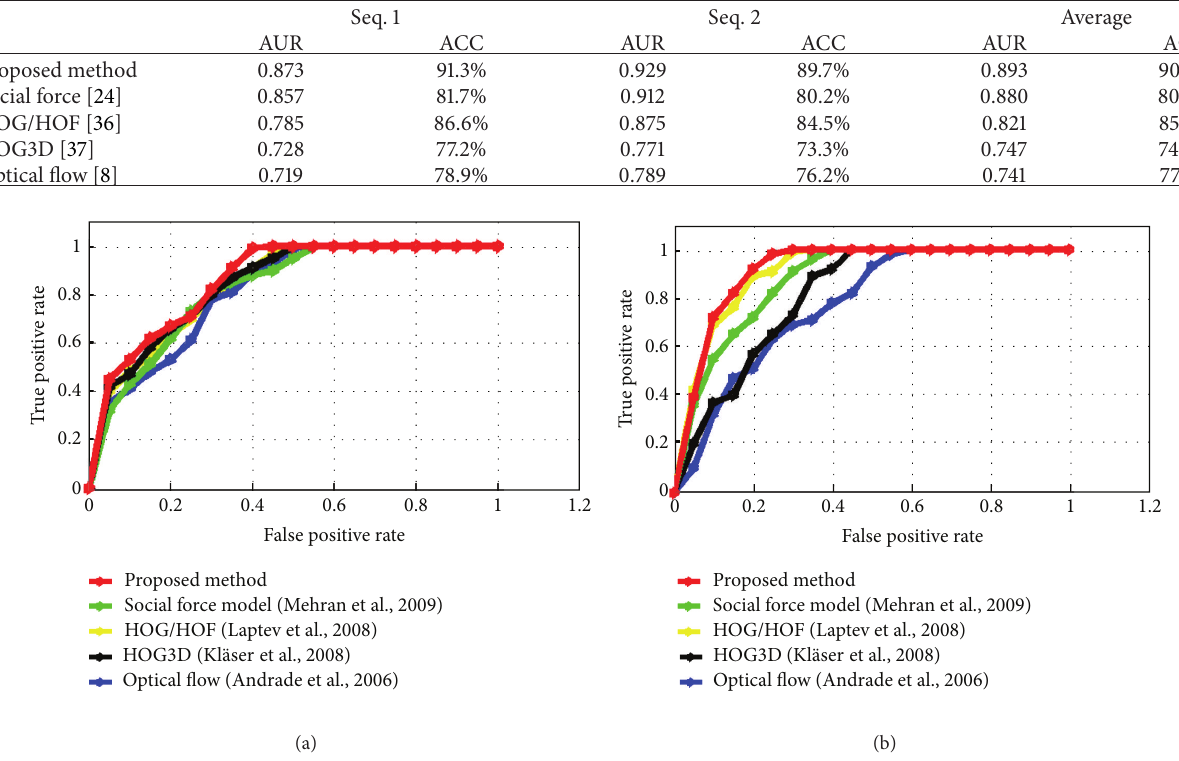
Figure 11: The ROC curves for the crowd behavior perception results based on our proposed spatiotemporal Weber field, social force